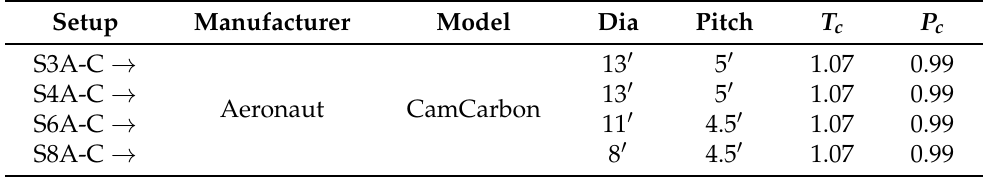
Table 1. Design of a modular drone: datasheet of the Aeronaut propellers defined per each